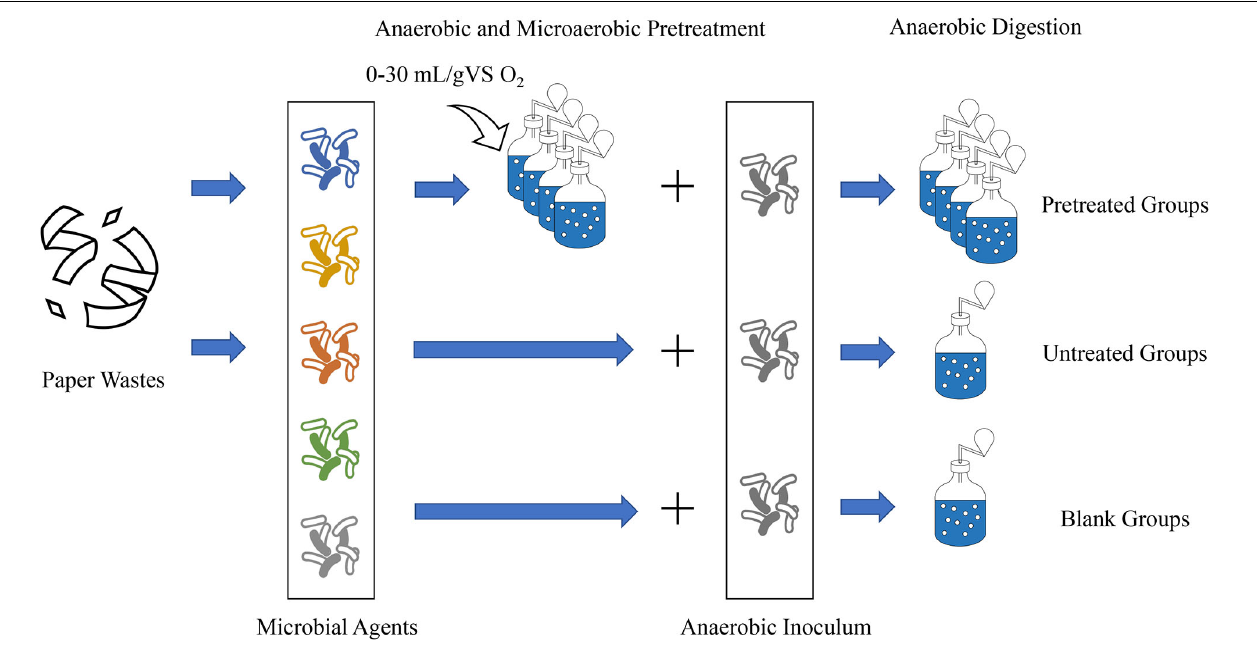
FIGURE 1 | Schematic diagram of the experimental